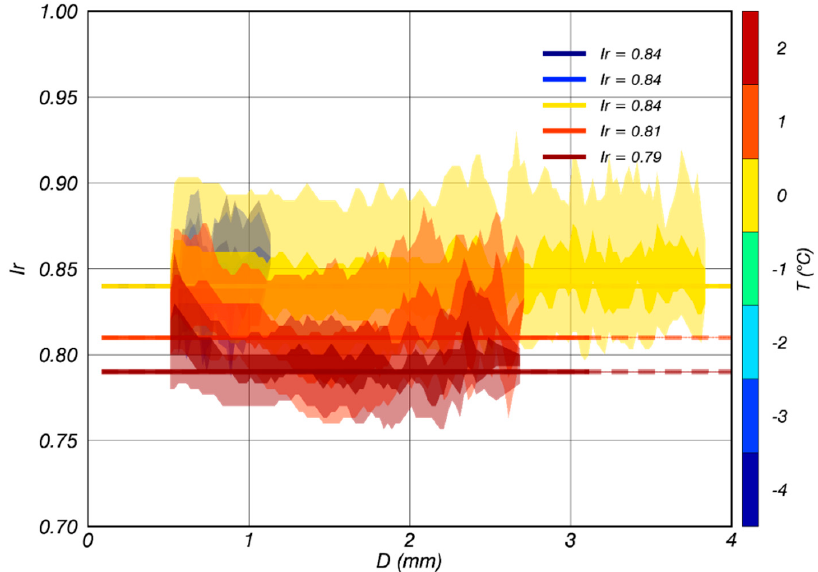
Figure 8. Color − shaded 2D histogram plots of Ir versus D for each T class. The color shades correspond to the data range of ± 10% and ± 25% from the median value.